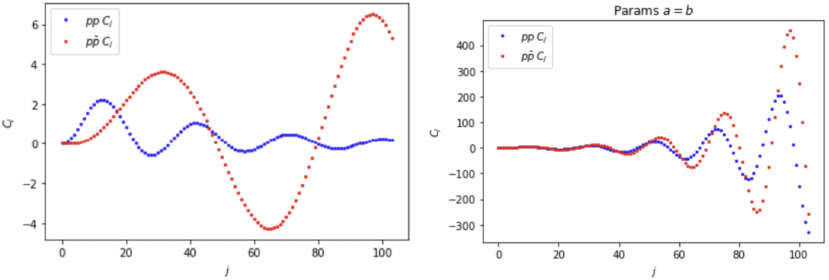
Figure 4: Oscillations in C from our model. The plot on the left is for a (cid:54) = b while j the one on the right is for a =